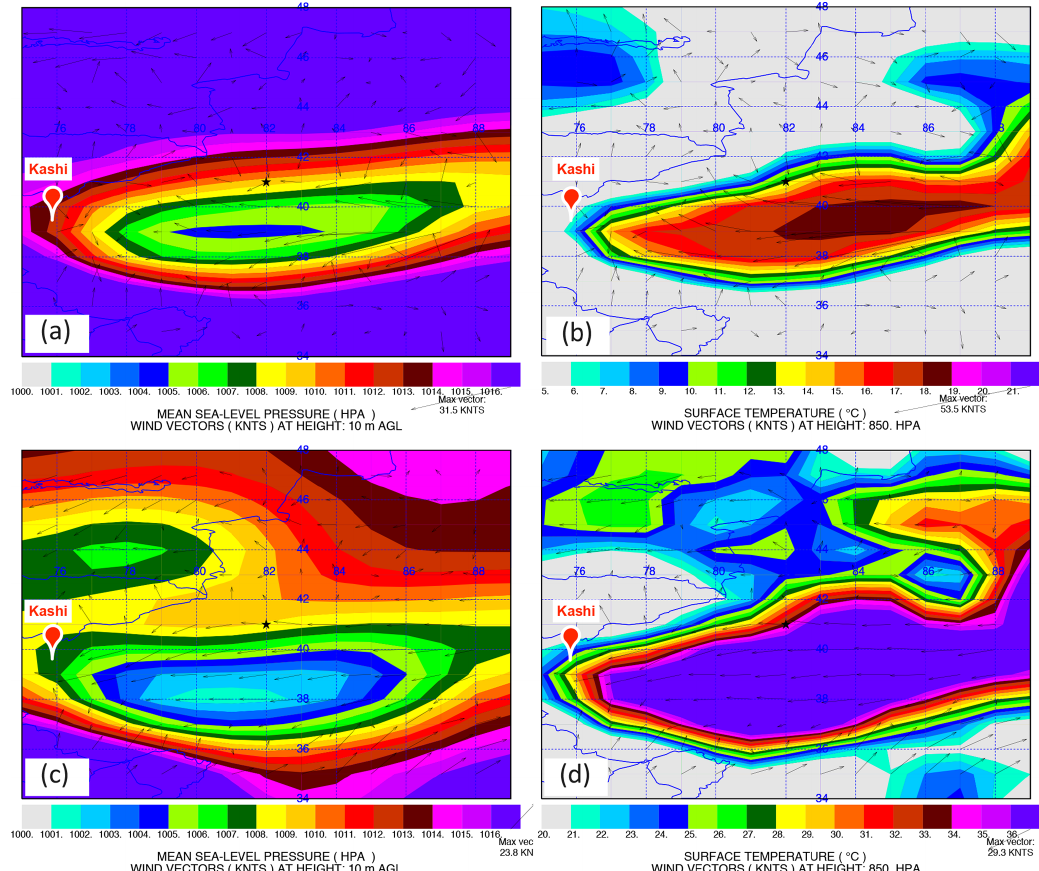
Figure 9. Case 2: the synoptic condition at 00:00UTC, 23 April (a, b) , and 06:00UTC, 24 April (c, d) , 2019. The data are obtained from the 1 ◦ GDAS archived meteorological data. (a, c) The mean sea level pressure at the surface overlaid with wind vectors at 10m above the ground level. (b, d) The temperature at 2m vertical level overlaid with wind vectors at 850hPa vertical level.